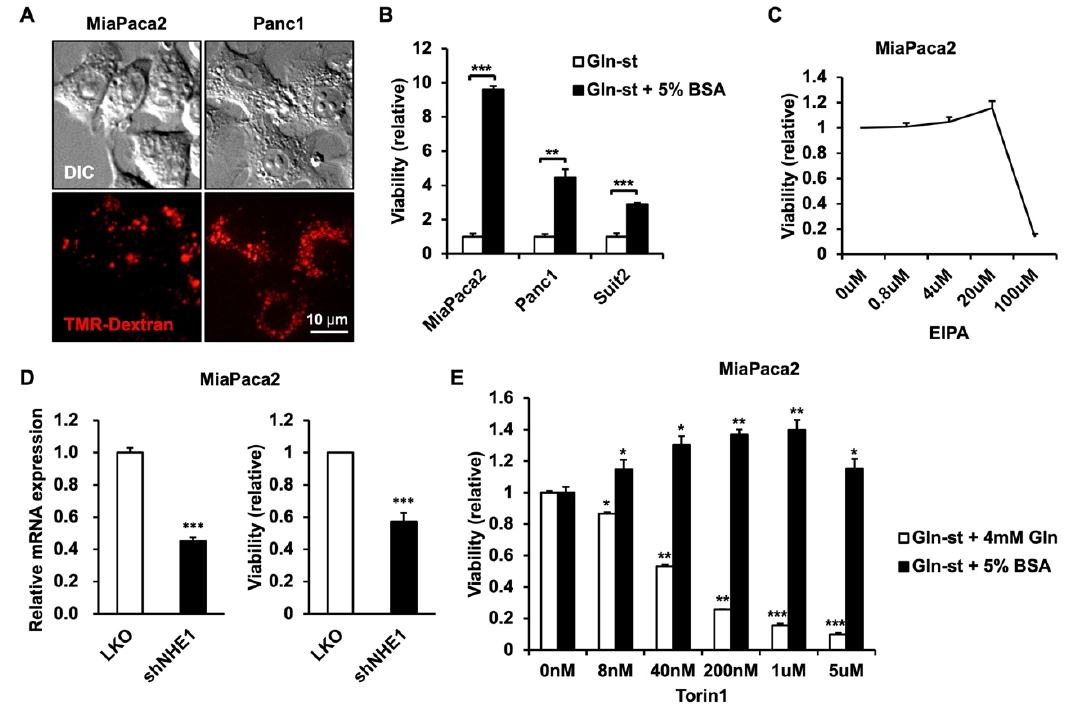
Figure 1. PDAC cells utilize extracellular protein to enhance survival in glutamine-deprived condi- tions. ( A ) Representative images of MiaPaca2 and Panc1 cells incubated with 70 kDa TMR–Dextran for 2 h, demonstrating macropinocytic uptake. ( B ) Relative viability of MiaPaca2, Panc1, and Suit2 showing the fold increase in viability induced by the supplementation of 5% BSA compared to glutamine starvation conditions for 3 days. The indicated p -values were obtained using Student’s t test (***, p < 0.001, **; p < 0.01). ( C ) Relative viability of MiaPaca2 cells cultured in glutamine starvation conditions supplemented with 5% BSA and treated with various concentrations of EIPA for 3 days. ( D ) Relative expression of NHE1 mRNA and corresponding viability of NHE1-depleted MiaPaca2 cells cultured in glutamine starvation conditions and supplemented with 5% BSA. ( E ) Rela- tive viability of MiaPaca2 cells cultured in glutamine starvation conditions supplemented with either 4 mM glutamine or 5% BSA and treated with various concentration of Torin1 for 3 days. Data in B, C, E are presented as mean +/ − SEM, n = 3; data in D are presented as mean +/ − SEM, n = 4. The indicated p -values were obtained using Student’s t test (*, p < 0.05, **, p < 0.01, ***, p <